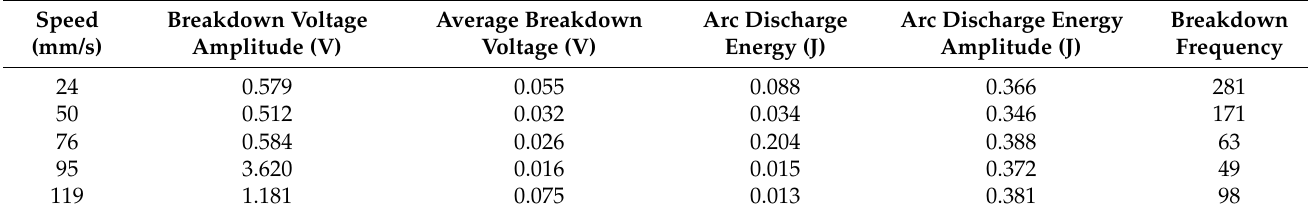
Table 6. Electrical breakdown of the contact couple in the air after 120 min sliding.